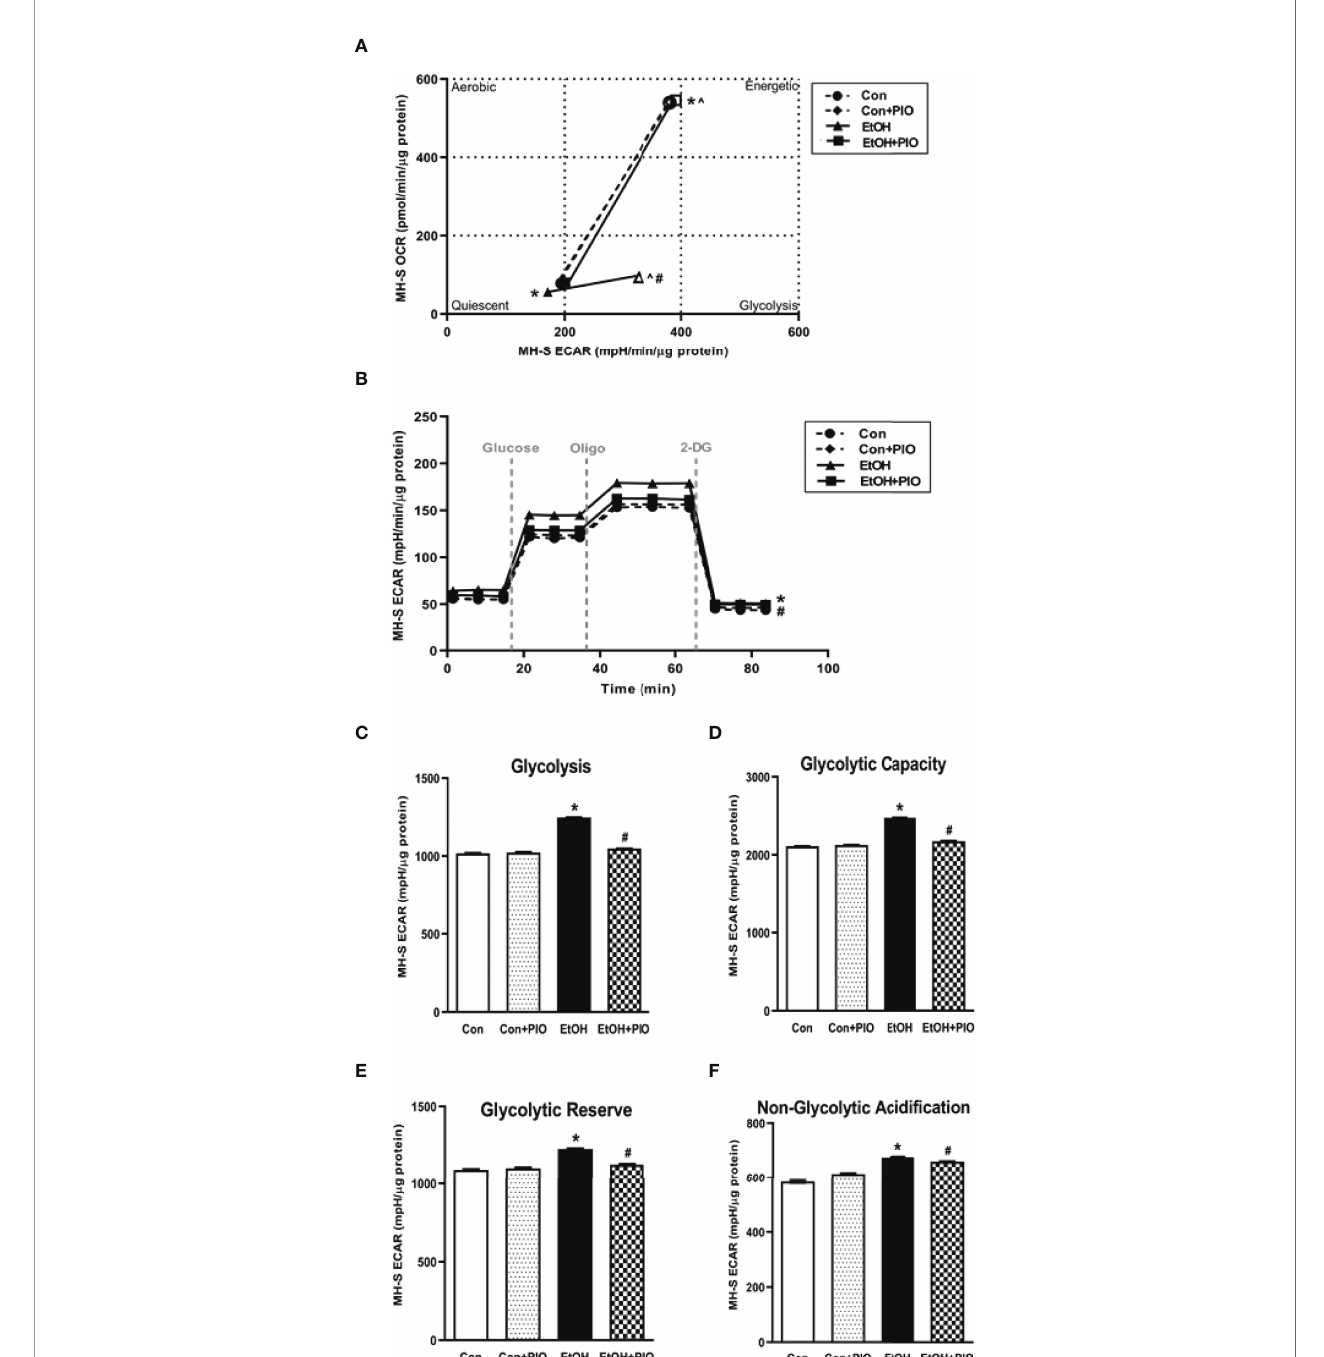
FIGURE 9 | Pioglitazone treatment reverses EtOH-induced glycolysis in MH-S. MH-S were exposed to either control (Con) or ethanol (EtOH; 0.08%; 72 hours) ± pioglitazone (PIO, last day of ethanol). (A) Oxygen consumption rates (OCR) and extracellular acidi fi cation rates (ECAR) were measured in response to an injection mixture of oligomycin (oligo; mitochondrial complex V inhibitor), carbonilcyanide p-tri fl ouromethoxyphenylhydrazone (FCCP; ATP synthase inhibitor and proton uncoupler) using an extracellular fl ux analyzer. Cell energy phenotype was measured, normalized to protein levels, and are expressed as mean ± SEM (n = 15). ECAR were measured in response to sequential injections of glucose (saturating concentration of glucose to promote glycolysis), oligomycin (ATP synthase inhibitor), and 2-deoxy-glucose (2-DG; a glucose analog that inhibits glycolysis) using an extracellular fl ux analyzer. OCR measures are pmol over time and ECAR measures are mpH over time, normalized to total protein in the same sample well, and are expressed as mean ± SEM. Parameters of glycolytic function (B) , glycolysis (C) , glycolytic capacity (D) , glycolytic reserve (E) , and non-glycolytic acidi fi cation (F) are expressed as mean ± SEM, relative to control (n = 15). * p < 0.05 verses control; # p < 0.05 versus ethanol; ^ p < 0.05 versus control